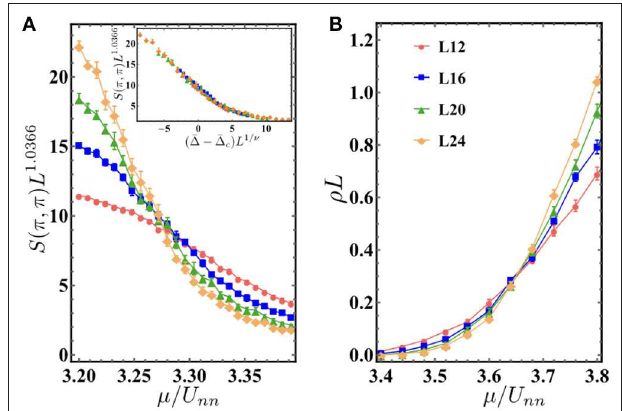
FIGURE 5 | Model 2 (nearest-neighbor repulsive interactions): all following results are at fixed disorder strength 1/ t = 3 and t / U nn = 0.2. (A) Main plot: finite size scaling of S ( π , π ) for system sizes L = 12, 16, 20, and 24 (red circles, blue rectangles, green up triangles, and orange diamonds, respectively). The crossing of different curves marks the transition point at µ/ U nn = 3.275 ± 0.02 for the DS to BG phase transition. Insert shows the data collapse result using ν = 0.67 and ¯ 1 c = ( µ/ U nn ) c = 3.275 corresponding to the critical point extracted from main plot. (B) shows the scaling of superfluid stiffness ρ L as a function of µ/ U nn for t / U nn = 0.2 for L = 12, 16, 20, and 24. The crossing of different curves marks the transition point at µ/ U nn = 3.652 ± 0.02 for the BG to SF phase